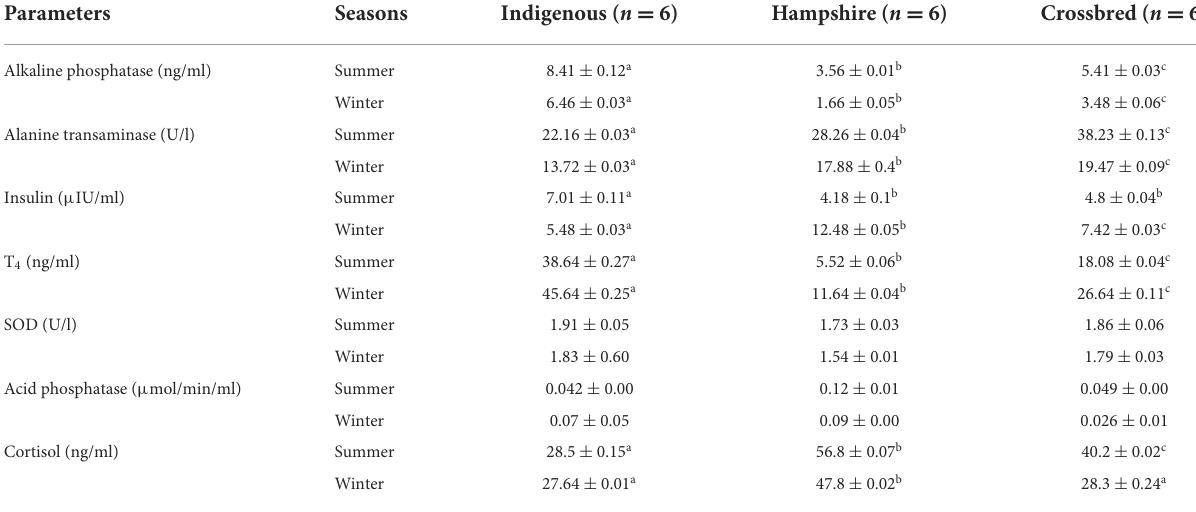
TABLE 4 Means ± SE of indigenous, Hampshire, and crossbred pigs for serum biochemical parameters during the study period.